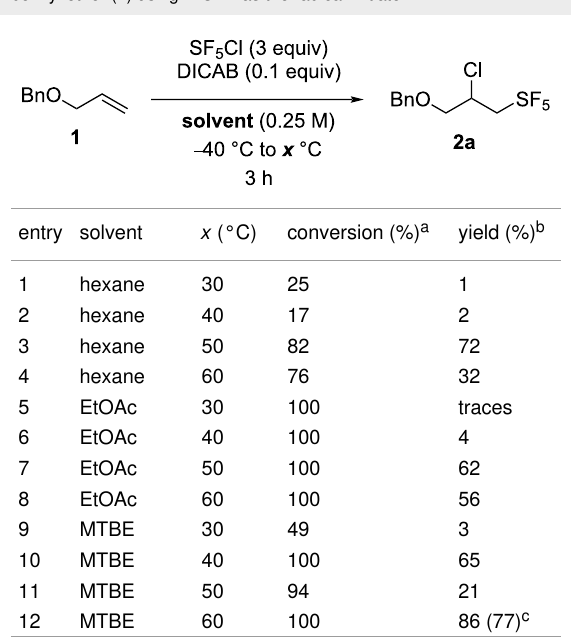
Table 2: Selected optimization results for the SF 5 Cl addition on allyl benzyl ether ( 1 ) using DICAB as the radical initiator.